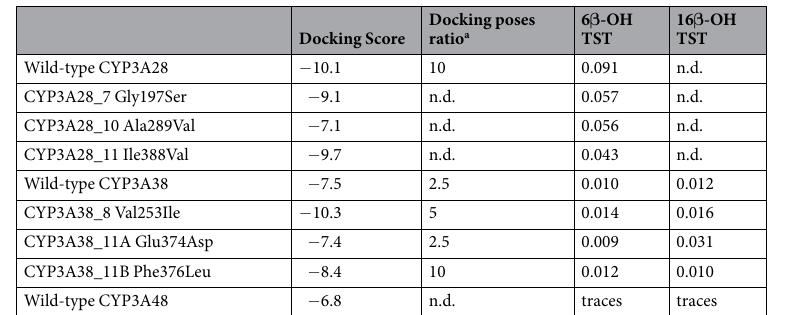
Table 3. Docking scores of TST and TST hydroxylation activities. a Approximate ratio of docking poses with carbon-6 to carbon-16 oriented towards heme. Activities are expressed as nmoles min − 1 mg − 1 protein with blank reactions subtracted. n.d.: not detectable.